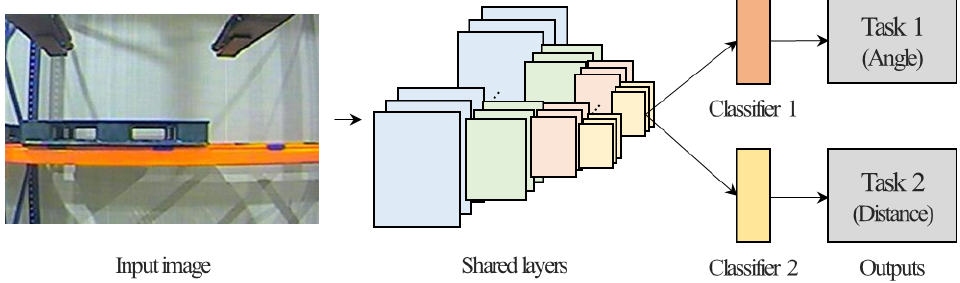
Figure 1. Overview of the proposed multi-task learning method for pallet recognition.